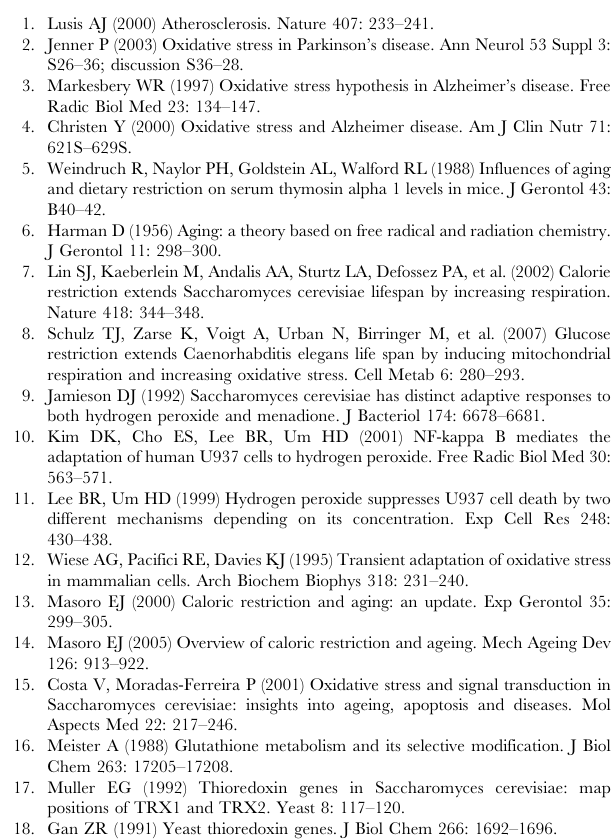
Dataset S1 Fitness Table: P-values for acute and adaptive screens conducted in this study. TXT) Dataset S2 Enrichment Summary: Differentially expressed or sensitive members of each significantly over-represented condition or transcription factor target set mentioned in the study. Dataset S3 Expression Table: Log ratios and p-values for all micro-array expression profiling experiments conducted in this study. TXT) Dataset S4 TFs Table: Table containing all of the transcription factor target sets used in this study.